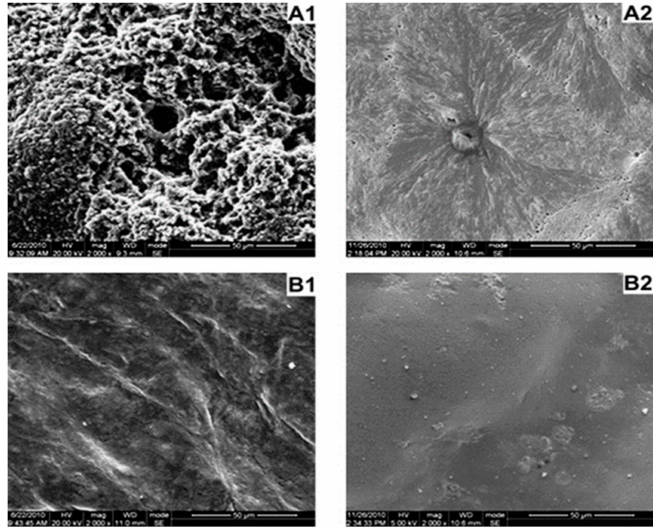
Figure 6. SEM images of char residue after cone calorimeter test: ( A1 , A2 ) the outer surface and the inner surface of PLA/IFR; and ( B1 , B2 ) the outer and inner surface of PLA/IFR/ α -ZrP2 (Adapted with permission from